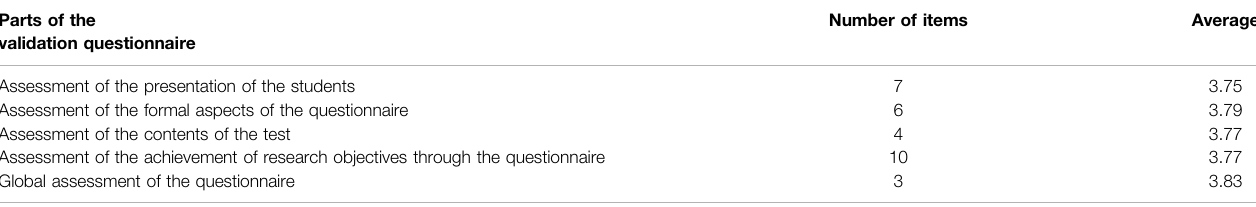
TABLE 1 | Averages of the items of the validation questionnaire.